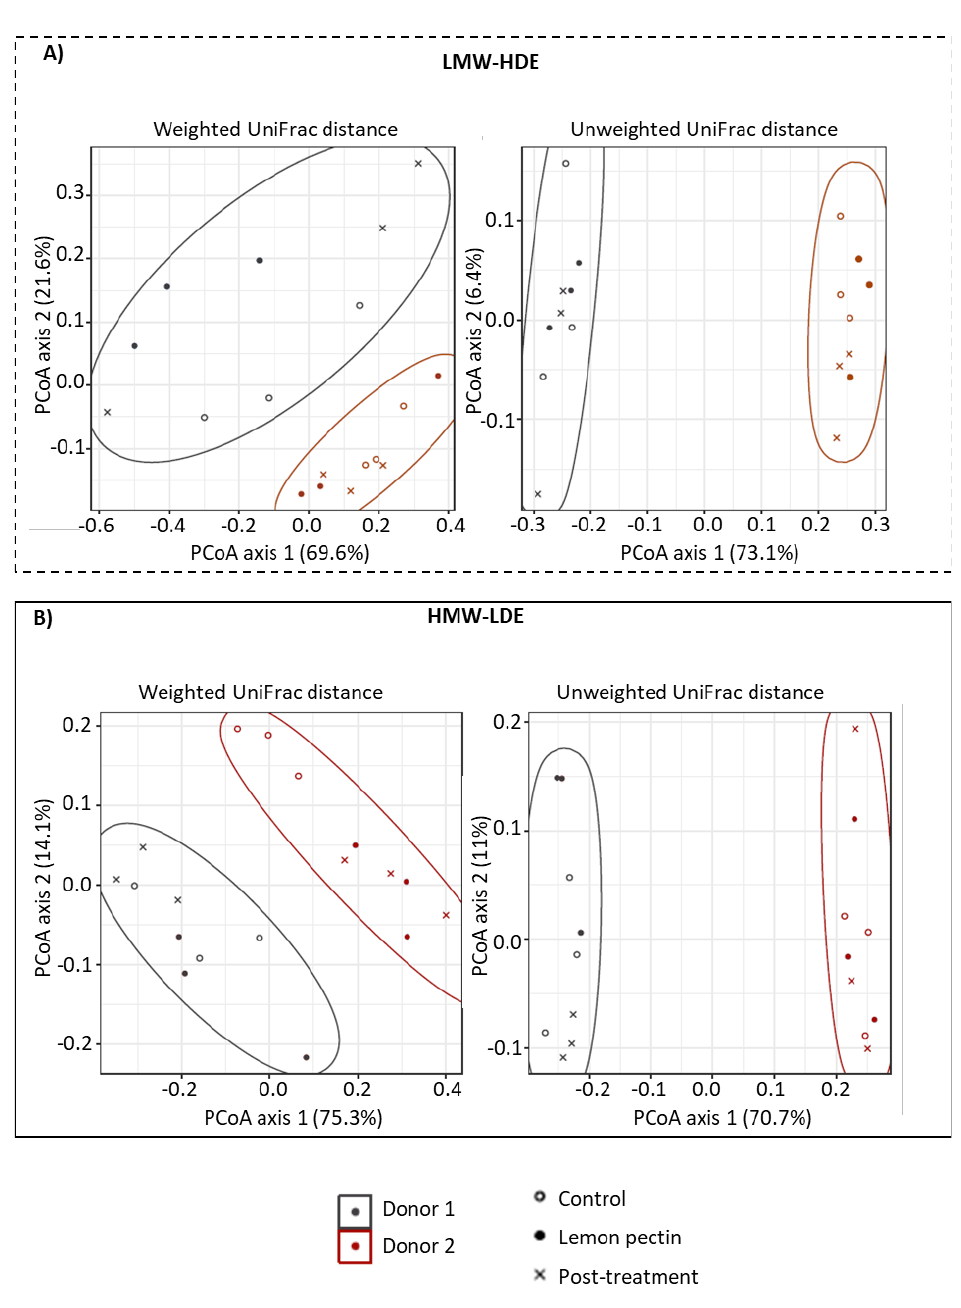
Figure 2. Principal Coordinate analysis (PCoA) based on weighted and unweighted UniFrac distances for both donors during the control, lemon pectin treatment, and post-treatment periods. ( A ) LMW- HDE lemon pectin; ( B ) HMW-LDE lemon